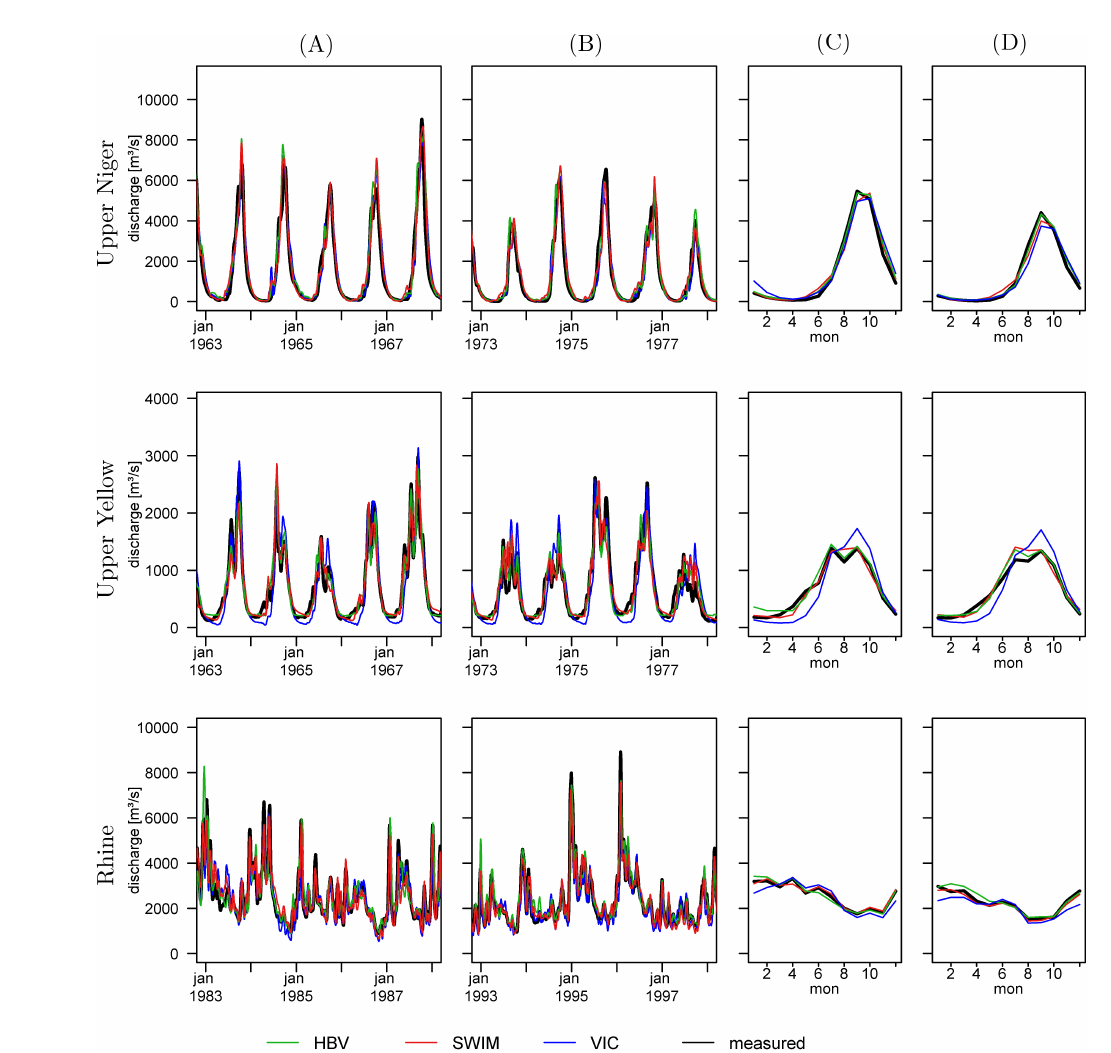
Figure 2. Results of calibration and validation of three models in three basins: comparison of the simulated and observed 30day moving- average discharges for 5 years in the calibration (a) and validation (b) periods, and comparison of the long-term average seasonal discharges in the calibration (c) and validation (d)